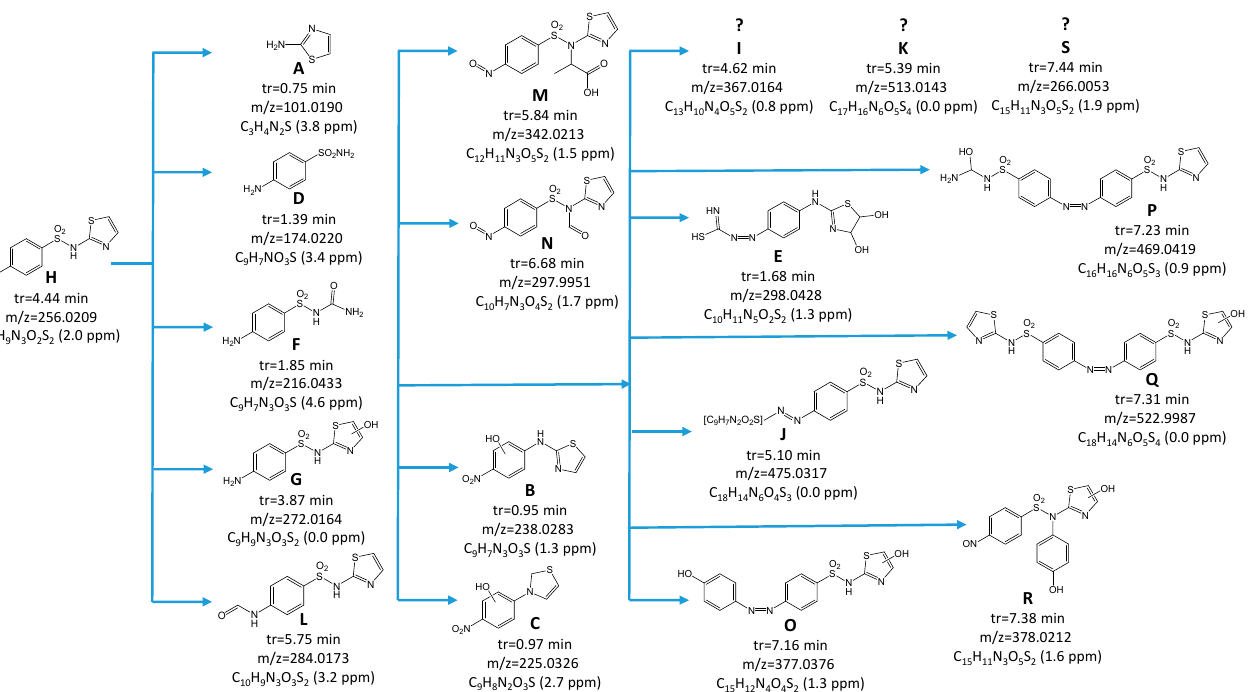
Figure 7. Proposed DPs identified based on the analysis of the chromatograms (Figure 6) and the possible pathway of STZ degradation.